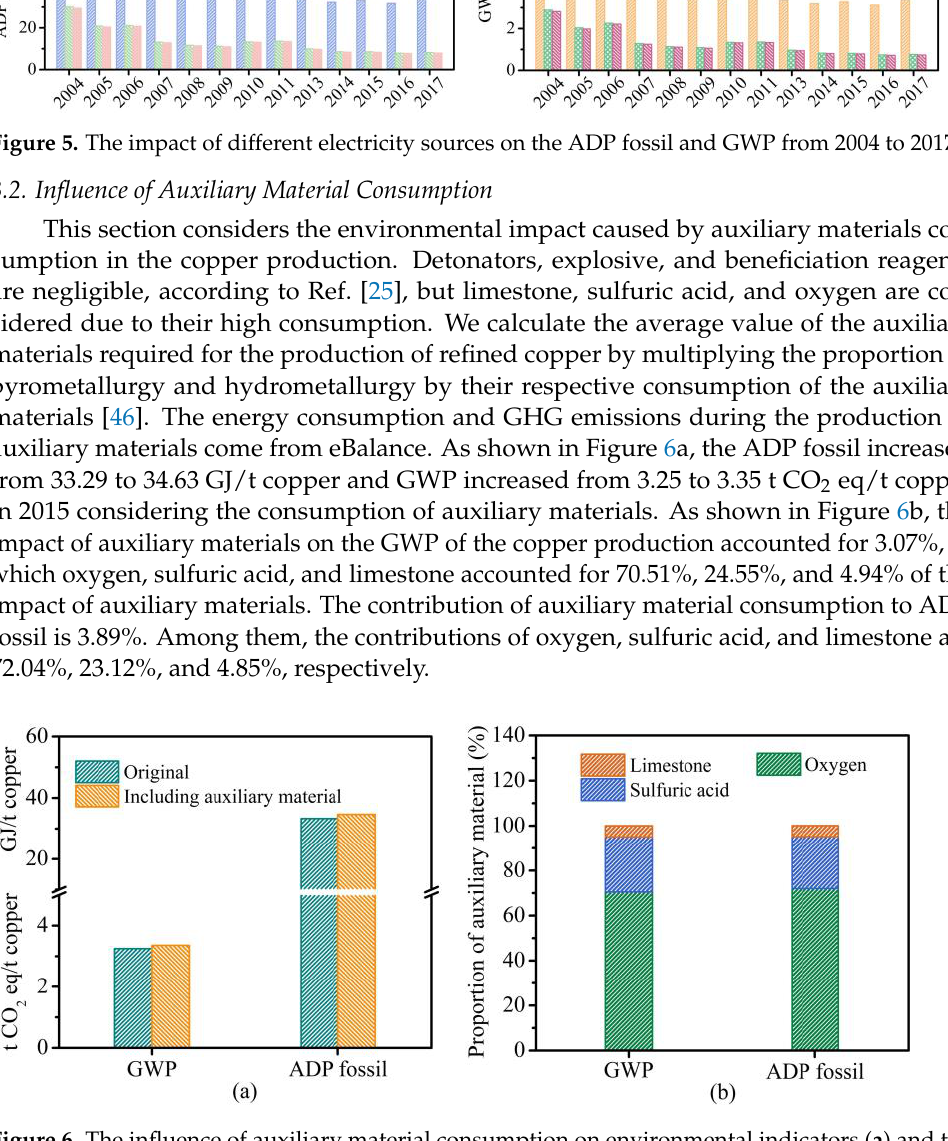
Figure 6. The influence of auxiliary material consumption on environmental indicators ( a ) and the contribution of limestone, oxygen, and sulfuric acid to the life cycle results of auxiliary material consumption ( b ).